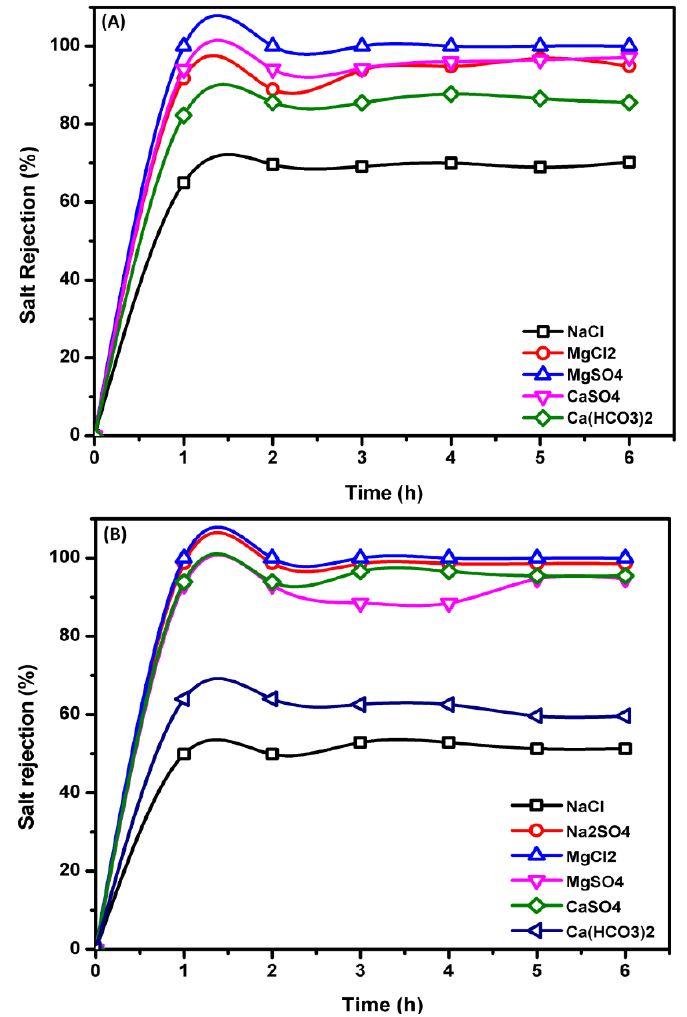
Figure 5. Hypothetical electrolytes rejection using NF membrane element of BWRO ( A ) and SWRO ( B ) brine concentrate operating conditions: pressure 0.7 MPa, operation time 8 h, operation temperature, 25 °C & flow rate, 5 L/min.